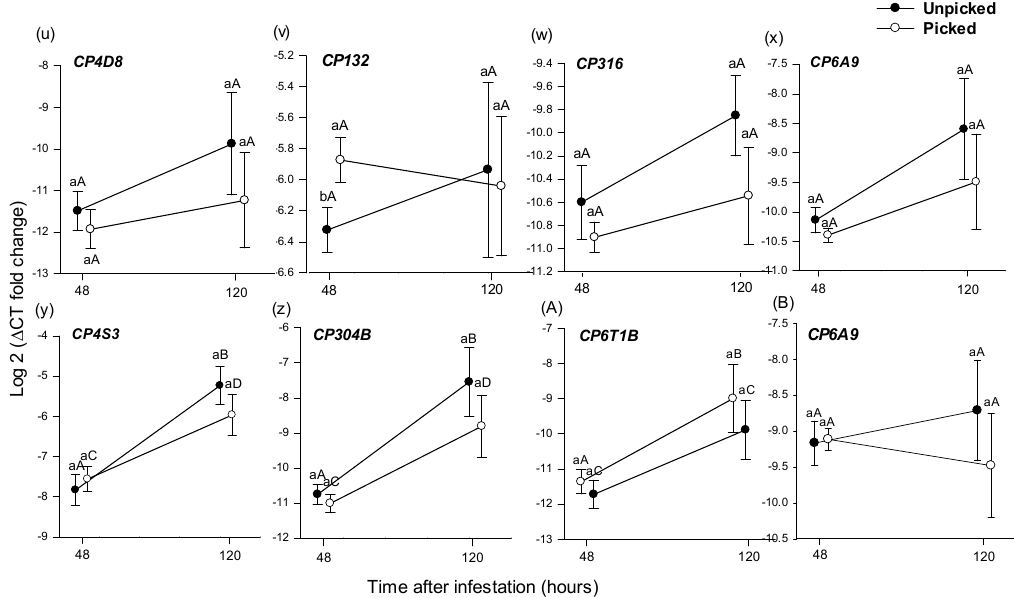
Figure 4. Mean (±1 SE) relative expression (log 2 of 2 −Δ CT ) of 28 putative detoxification genes ( a – z , A , B ), as assessed using RT-qPCR, from Bactrocera tryoni larvae extracted from Roma tomato at the colour-break ripening stage. Comparisons are of genes extracted from larvae sampled from fruit at two time periods (48 h and 120 h), after larval inoculation and of two picking states (unpicked and picked); n = 8 fruit for 48 h and n = 7 for 120 h time points and picking status. Lower-case letters reflect significance or otherwise in the comparison across picking status within a time point; upper- case letters reflect significance or otherwise in the comparison within picking status across time points. Table 5. Statistical analysis results of differential gene expression in Bactrocera tryoni larvae reared in unpicked or picked colour-break Roma tomato fruit and collected in 48 h and 120 h after inocu- lation (when larvae were approximately in their 1st and 2nd instars). The comparative analyses were performed between the following: (A) gene expression from tissue of larvae sampled from unpicked versus picked tomato fruit 48 h after larval inoculation; (B) gene expression from tissue of larvae sampled from unpicked versus picked tomato fruit 120 h after larval inoculation; (C) gene expres- sion from tissue of larvae sampled from unpicked tomato fruit 48 h versus 120 h after larval inocu- lation; and (D) gene expression from tissue of larvae sampled from picked tomato fruit 48 h versus 120 h after larval inoculation. Analyses were unpaired t -test or Mann–Whitney U test, depending on the error distribution of the data. The 28 selected genes are associated with insect detoxification pathways and are as follows: (1) cytochrome P450 ( CP6A9, CP313, CP134, CP4D8, CP6G1, C12E1, CP6T1A, CP6T1B, C12C1, C12B1, C12B2, CP304A, C304B, CP306, C6A14, C4AC2, CP4S3, CP132, CP316 and CP6G2 ); (2) carboxylesterase ( EST F and EST 1 ); (3) glutathione S-transferase ( GST D1 , GST T1 and GST T7 ); (4) ATP-binding cassette (ABC) transporters ( ABCG1 , ABCA3 , SUR , L259 and MDR49 ). *: p < 0.05.